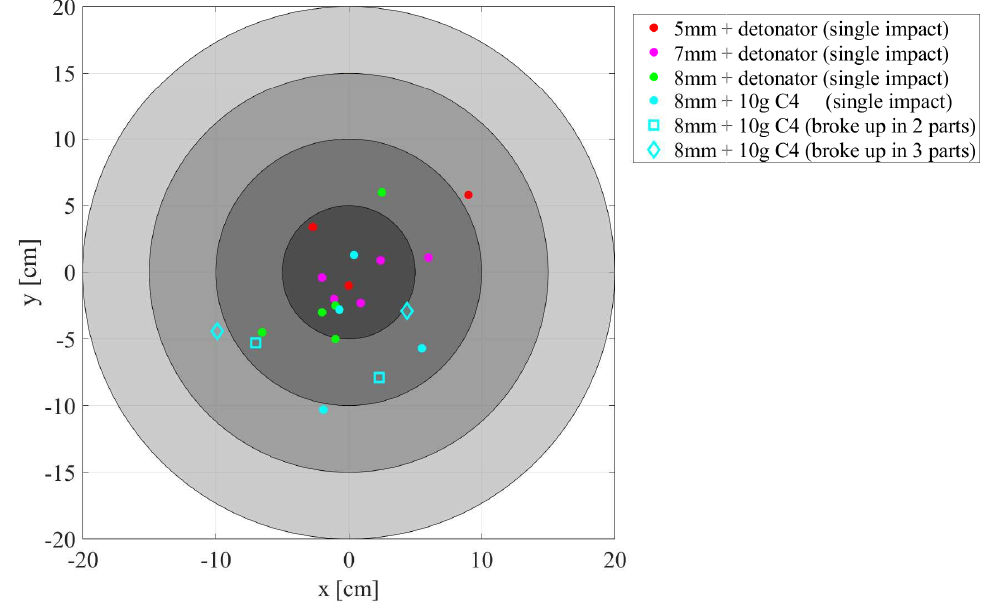
Figure 5. Representation of the dispersion of projectile impacts on the target using varying spheres (5, 7, and 8 mm) attached either to only a detonator or to a 10 g C4 spherical explosive